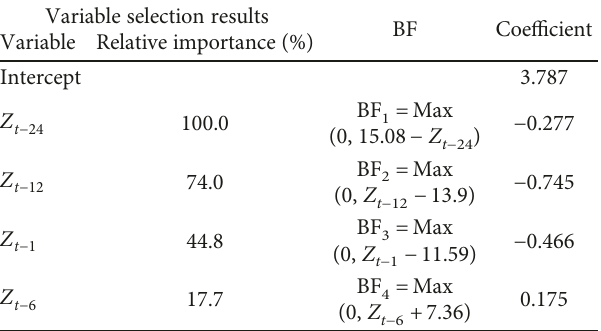
Table 15: The results of ARIMA-MARS for corn price